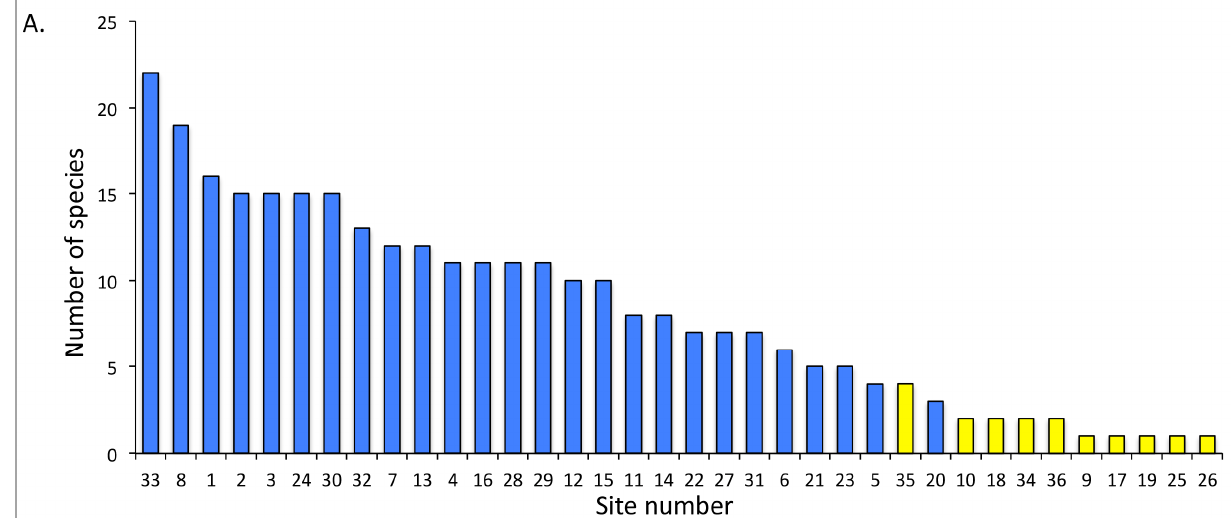
Figure 5. Patterns of fish diversity and density in sulphidic springs and adjacent non-sulphidic reference habitats of Southern Mexico. ( A ) Bar graph depicting the number of species collected at each site during the multiple-year, qualitative surveys; ( B ) Estimated marginal means (± s.e.m) for the number of species per site from quantitative surveys; ( C ) Estimated marginal means (± s.e.m) for the density of individuals per site from quantitative surveys. Estimated marginal means were derived from ANCOVA models as described in the main text. Non-sulphidic sites are in blue, sulphidic sites are in yellow. Site numbers correspond to IDs in Table